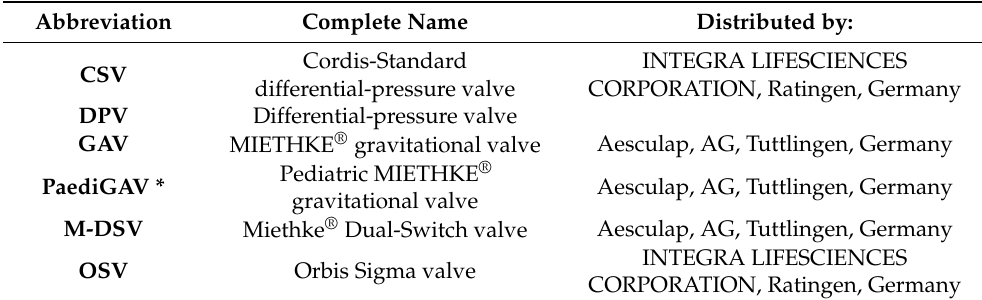
Table 3. Abbreviations and complete names of the valves mentioned in this